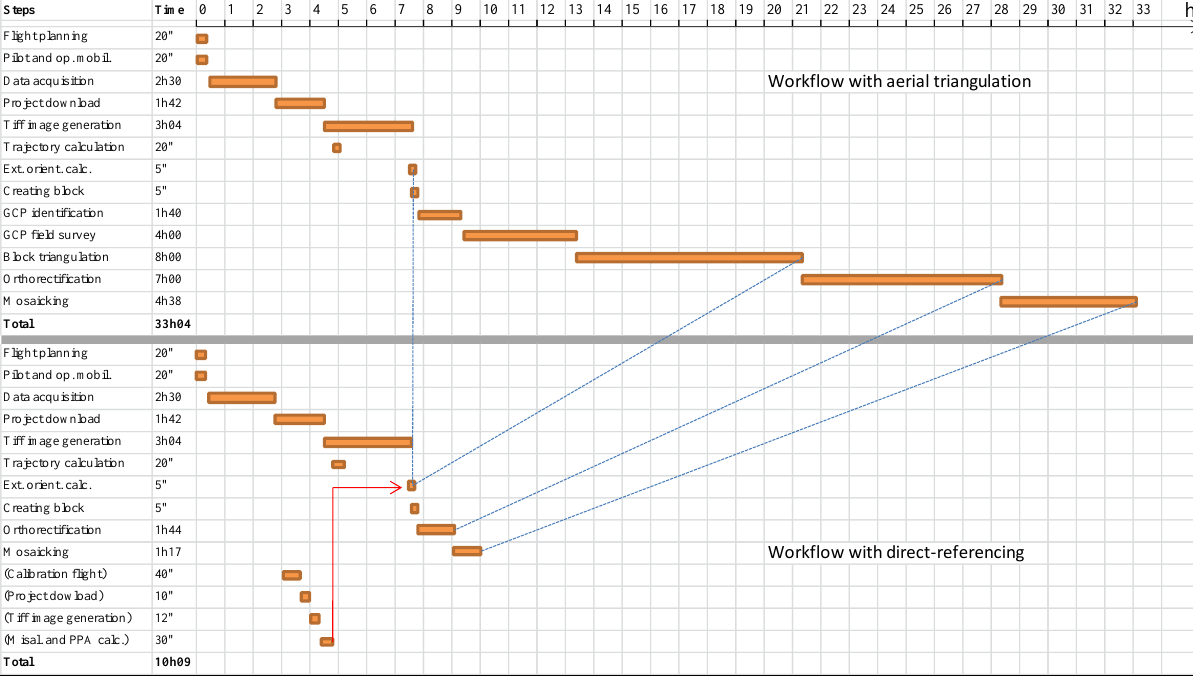
Figure 2. Gantt chart with comparison of normal and shortened workflows